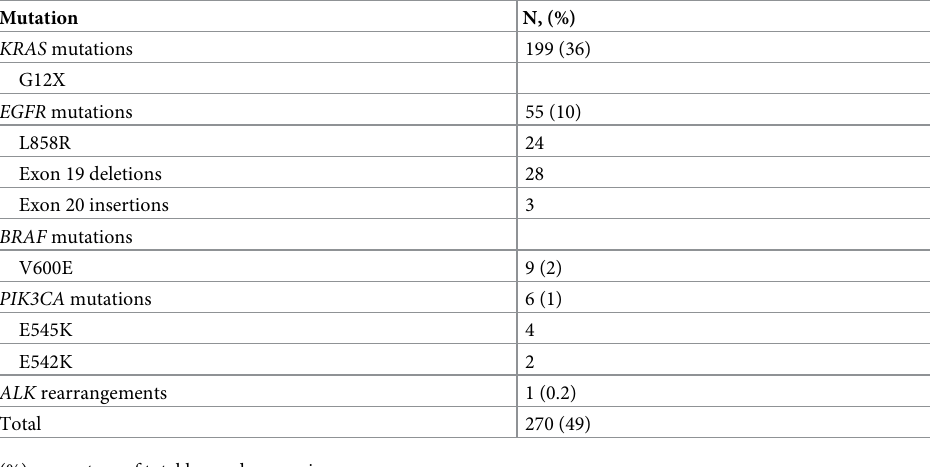
Table 1. Details of molecular alterations in lung adenocarcinoma cohort. Mutation N,